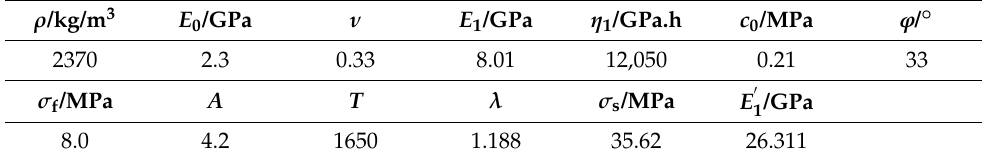
Table 2. Numerical simulation parameters of the model.